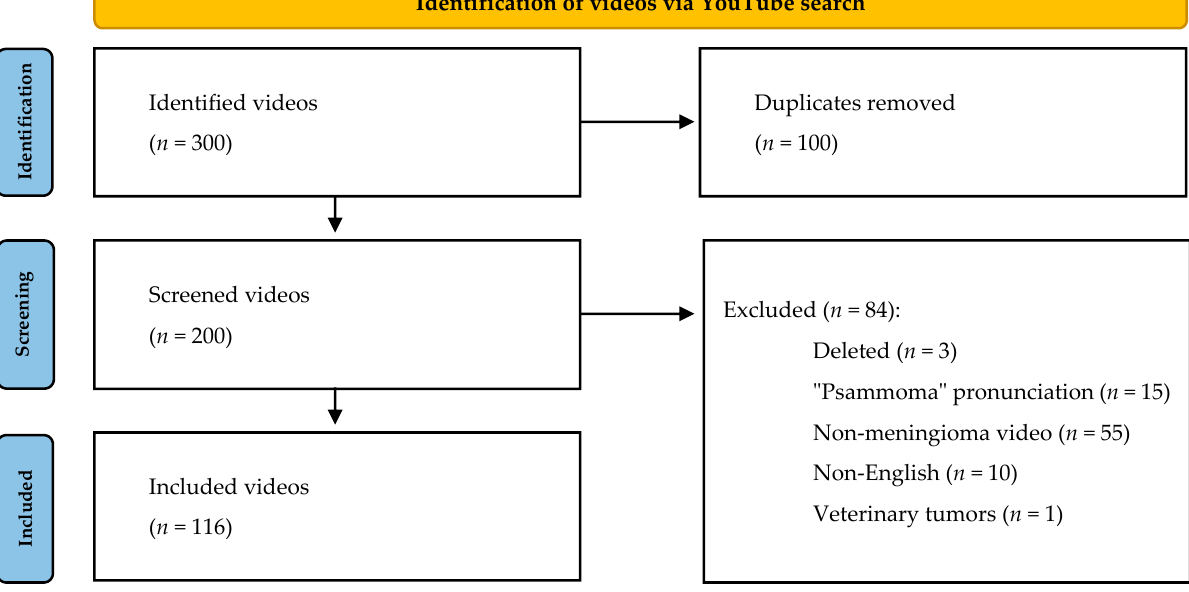
Figure 1. Video study inclusion.